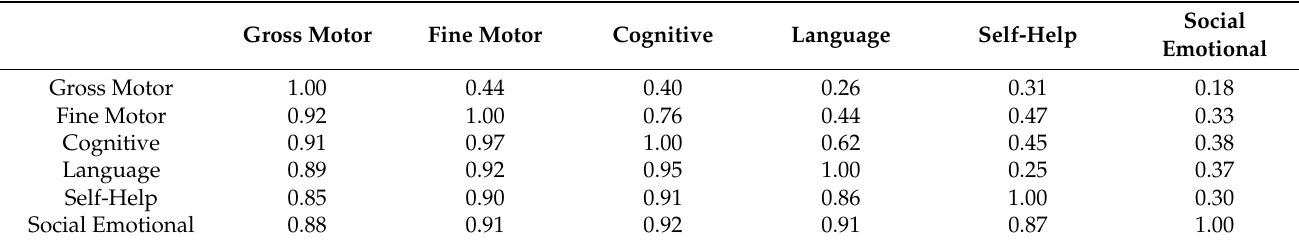
Table 7. Zero-order correlations and partial correlations, controlled for age, among the C-LAP’s six domains among participants from other provinces between 2013 and 2015.